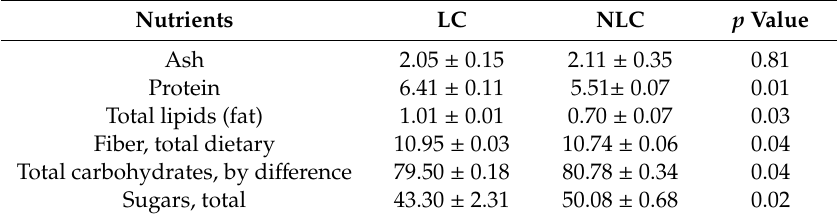
Table 1. Proximate composition of local sweet cherry (LC) and non-local sweet cherry